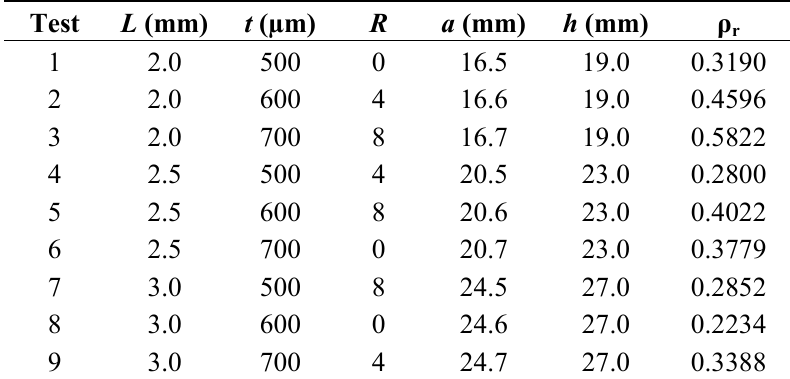
Table 8. Fractional plan used for the experimental